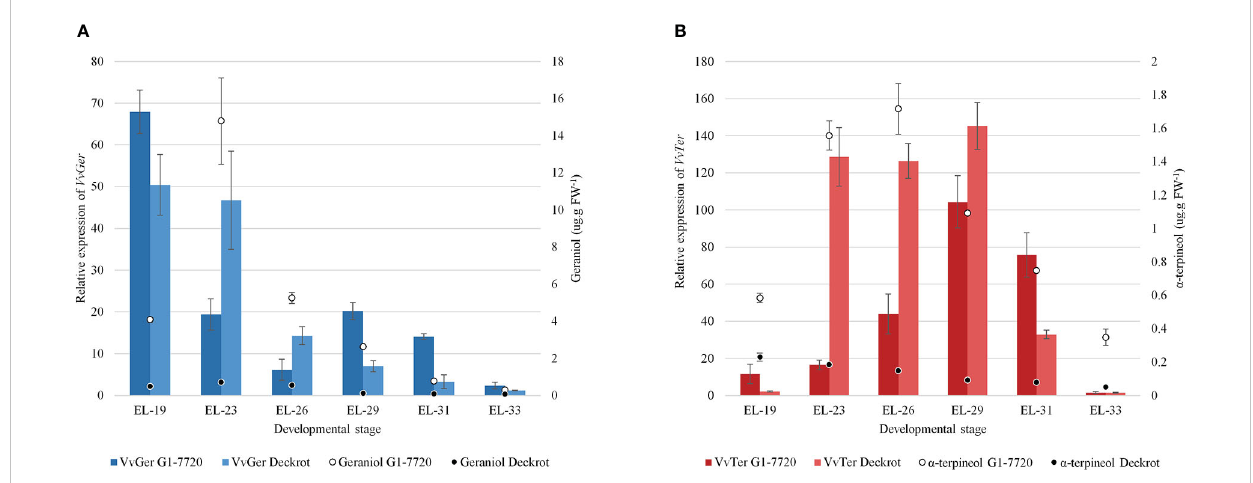
FIGURE 5 The expression of (A) VvGer and (B) VvTer in the parental cultivars, ‘ Deckrot ’ and G1-7720, during early berry development. The a-terpineol and geraniol concentrations at each stage is shown (values on right-side y-axis). n = 3; error bars represent standard